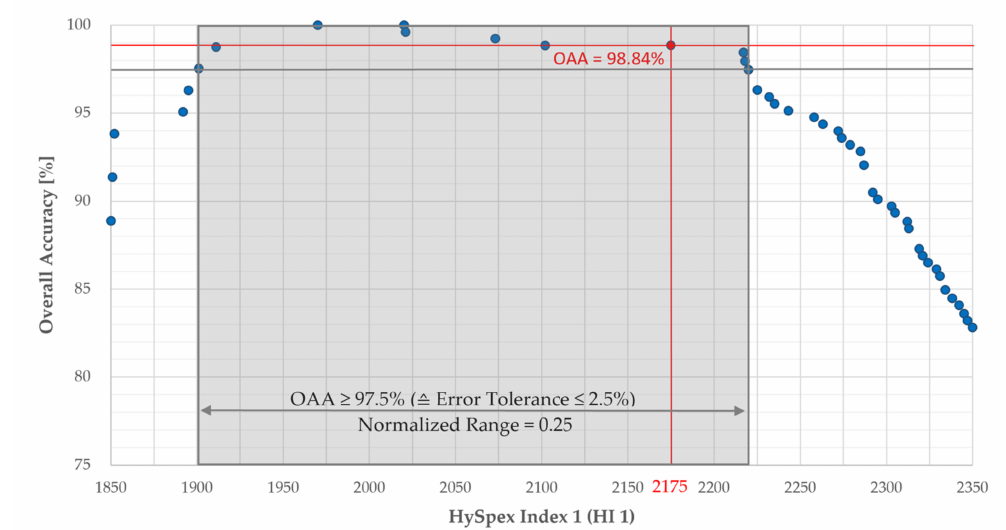
Figure 12. Normalized variations of the overall accuracy (OAA) for all central pixels of T1–3 using HySpex index 1 (HI 1). If the threshold for differentiating infested and healthy spruces (T1–3) is between 1970 and 2020, the OAA is 100% (see Figure 10). A large range of values from 1911–2220 still allows a very high OAA of ≥ 97.5% or error tolerance ≤ 2.5% (normalized range = 0.25). The threshold value 2175 was chosen for the classification (OAA = 98.84%) (see Figure 11). Overall, six spruces were unambiguously infested (green attack, dotted yellow circle), five spruces were infested (green attack, yellow circle), three spruces were unambiguously infested (brown crown, dotted red circle) and two spruces were infested (brown crown,